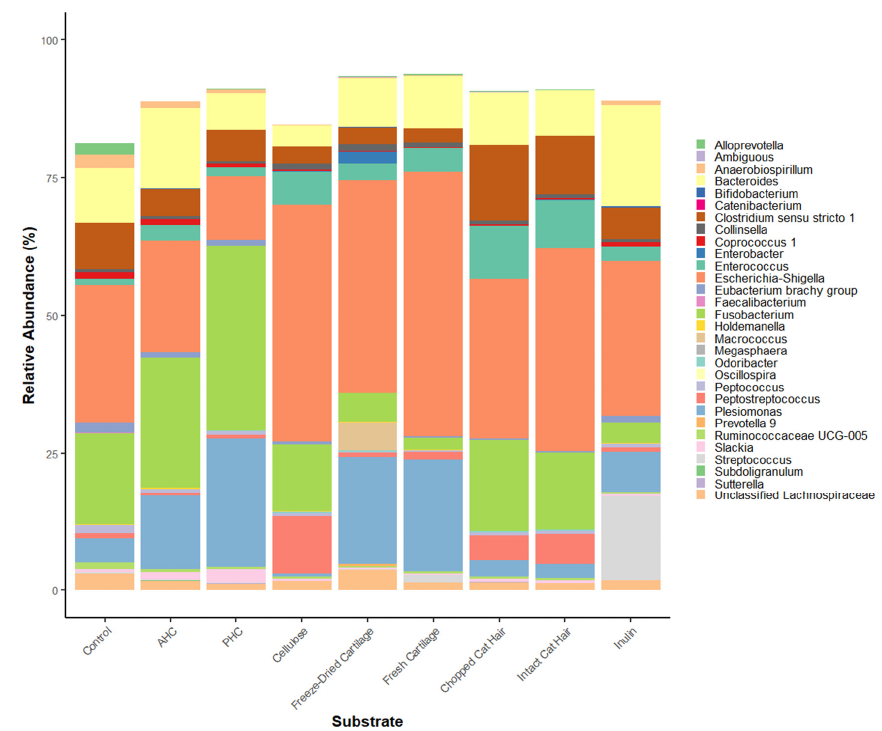
Figure 3. Barplot of the relative abundance of the top 30 bacterial genera present at 24 h in the in vitro fermentation system of the high protein faecal inoculum (PD) according to substrate. Each colour in the bar plot represents a bacterial genus, with the size of the bar denoting their relative abundance.